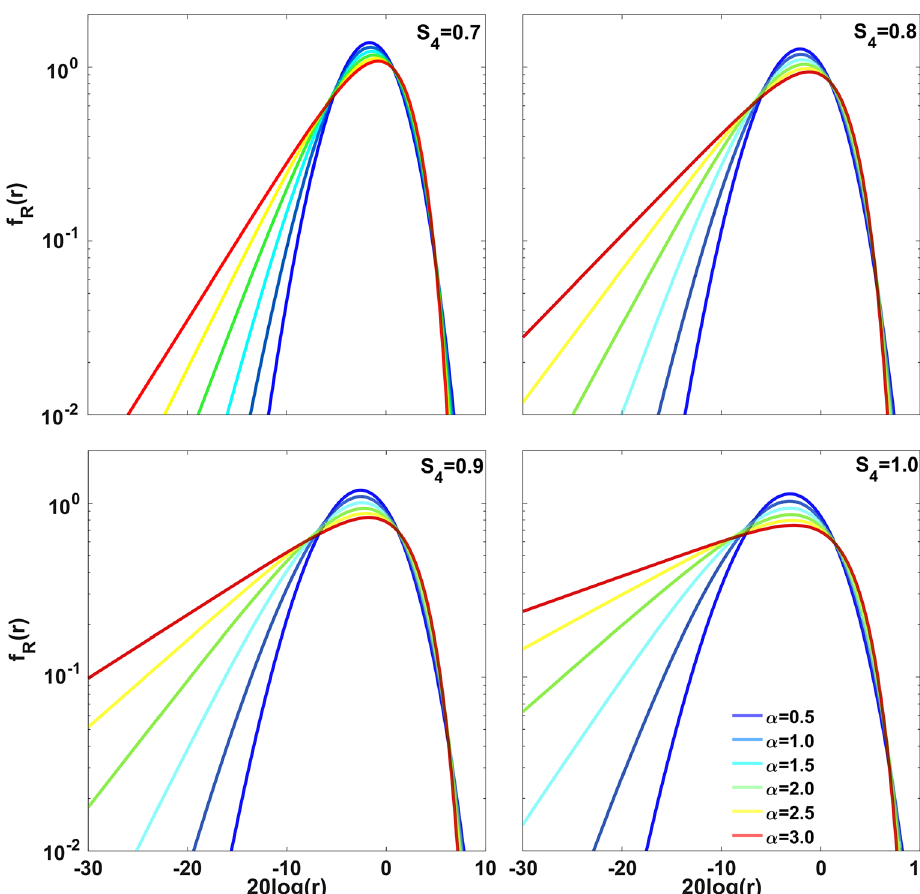
Fig. 5. Various shapes of a - l density function for single values of S 4 showing the versatility of this model.